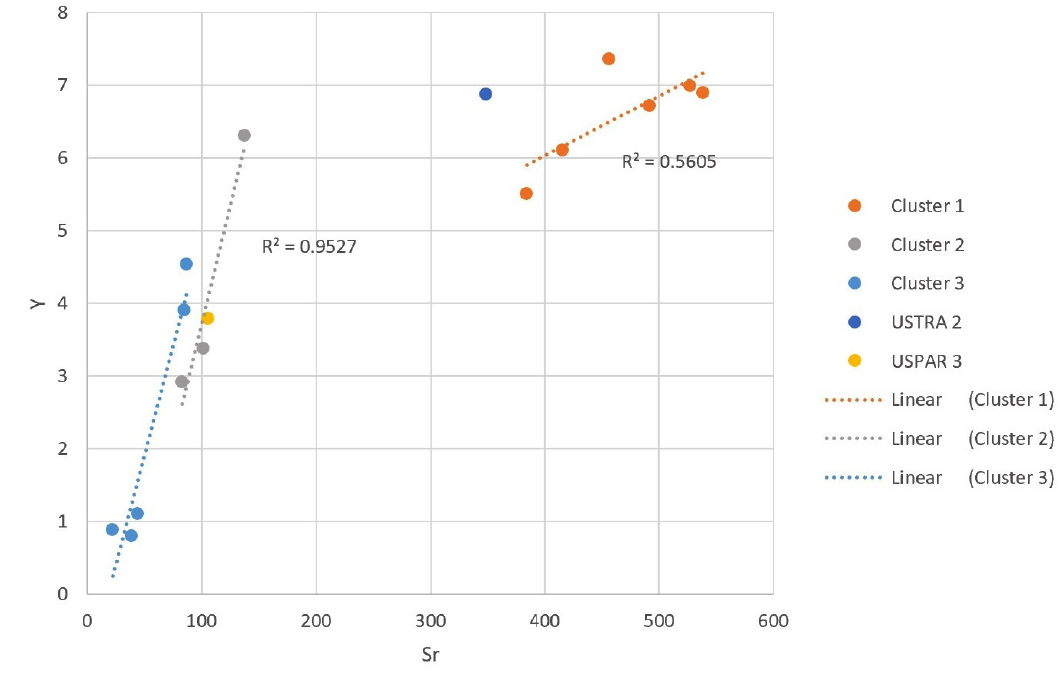
Figure 9: Correlation of strontium and yttrium according to clusters.